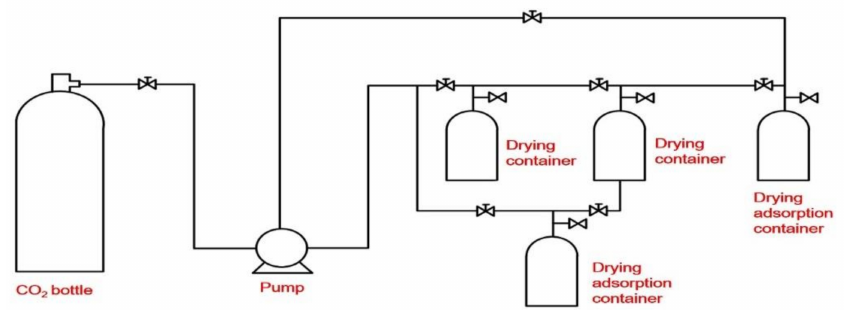
Figure 1. Supercritical CO 2 drying